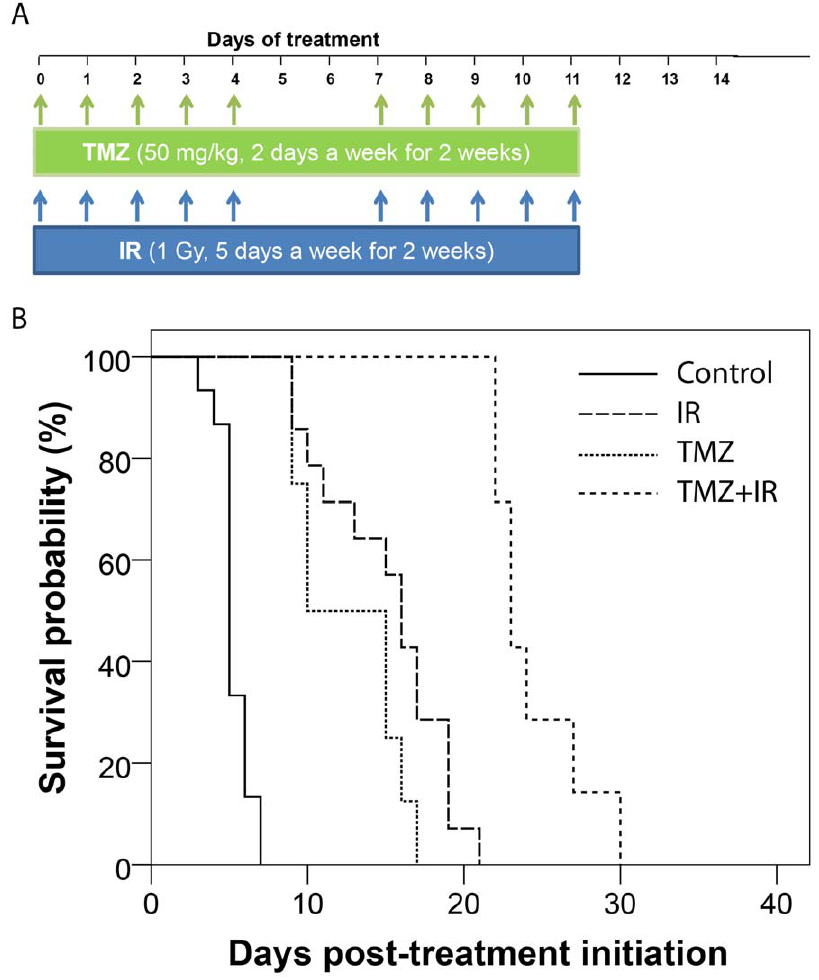
Figure 1. Kaplan-Meier survival plots are presented for each therapy in Study1 . (A) Schematic of treatment schedule for study 1 . Animals were randomized into four groups: control [DMSO/saline], irradiation (IR) [DMSO/saline followed by 1 Gy with 3 hour lag in between treatments], TMZ [50 mg/kg in DMSO/saline] and TMZ + IR [50 mg/kg in DMSO/saline followed by 1 Gy with a 3 hour lag time between treatments]. All treatments were administered five days a week for two weeks.(B) Treatment groups are Controls, irradiation (IR), temozolomide (TMZ) and combination temozolomide and irradiation (TMZ + IR).